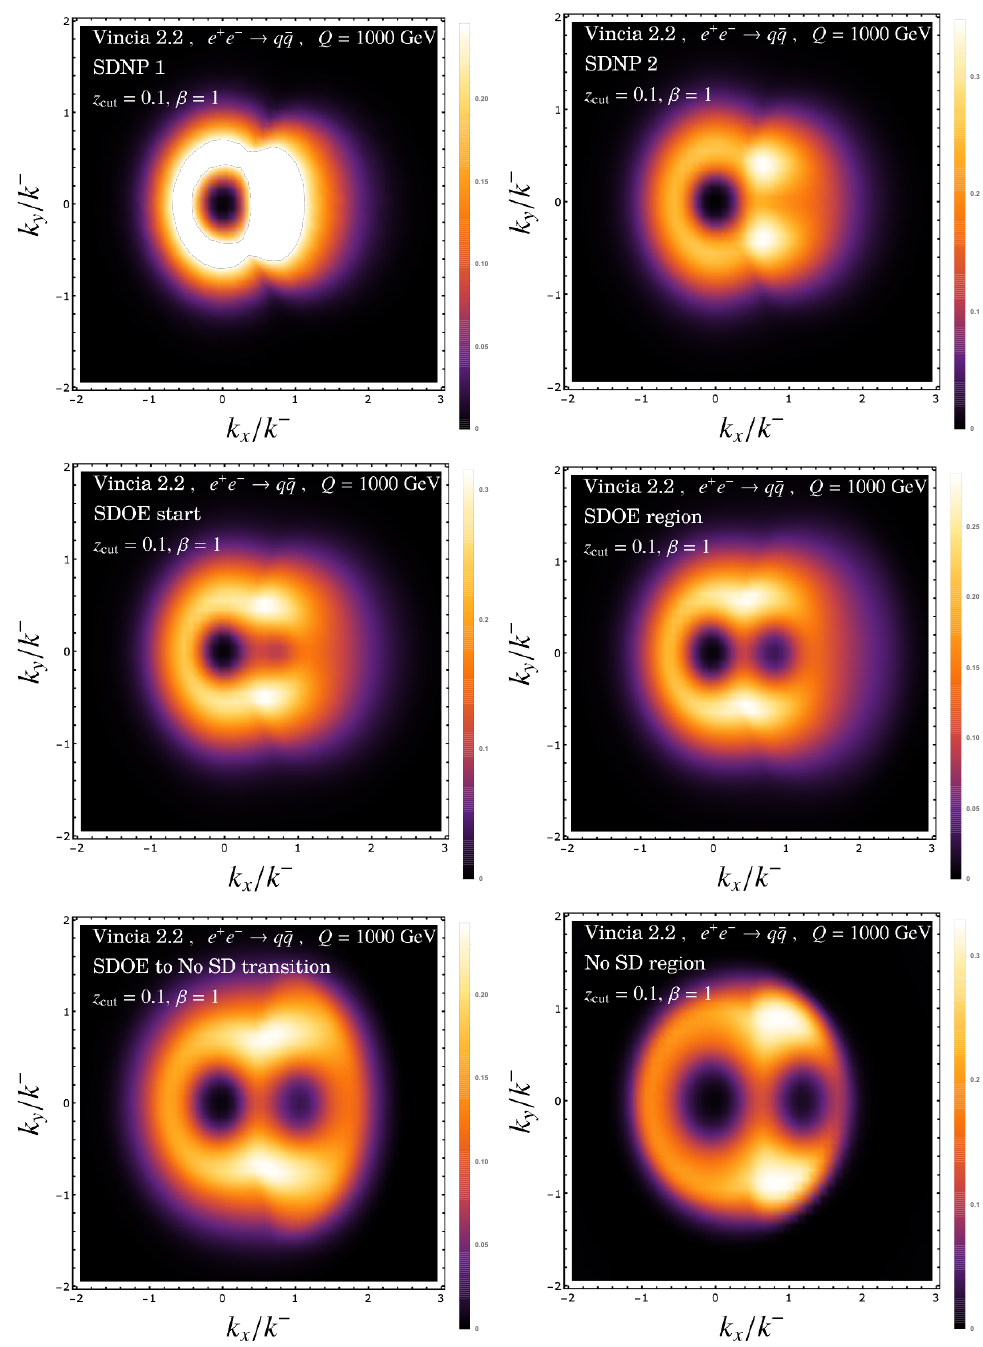
Figure 18 . \Heat maps" showing probability distribution of the angular location of the NP subjet in the plane perpendicular to the jet axis in rescaled coordinates for di(cid:11)erent regions of jet mass spectrum.